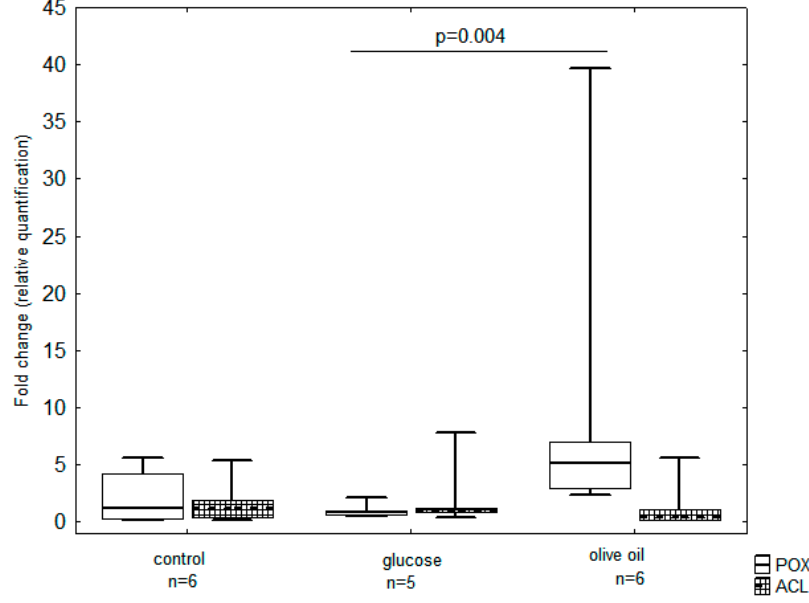
Figure 4. Average expression of the POX2 and ACL genes in yeast cells of Y. lipolytica KKP 379 during batch cultures in control YPG medium, MG7(containing glucose), and MO5 (containing olive oil) media. The results are presented as the median (line), the percentile range (frame), and the range of minimum-maximum.